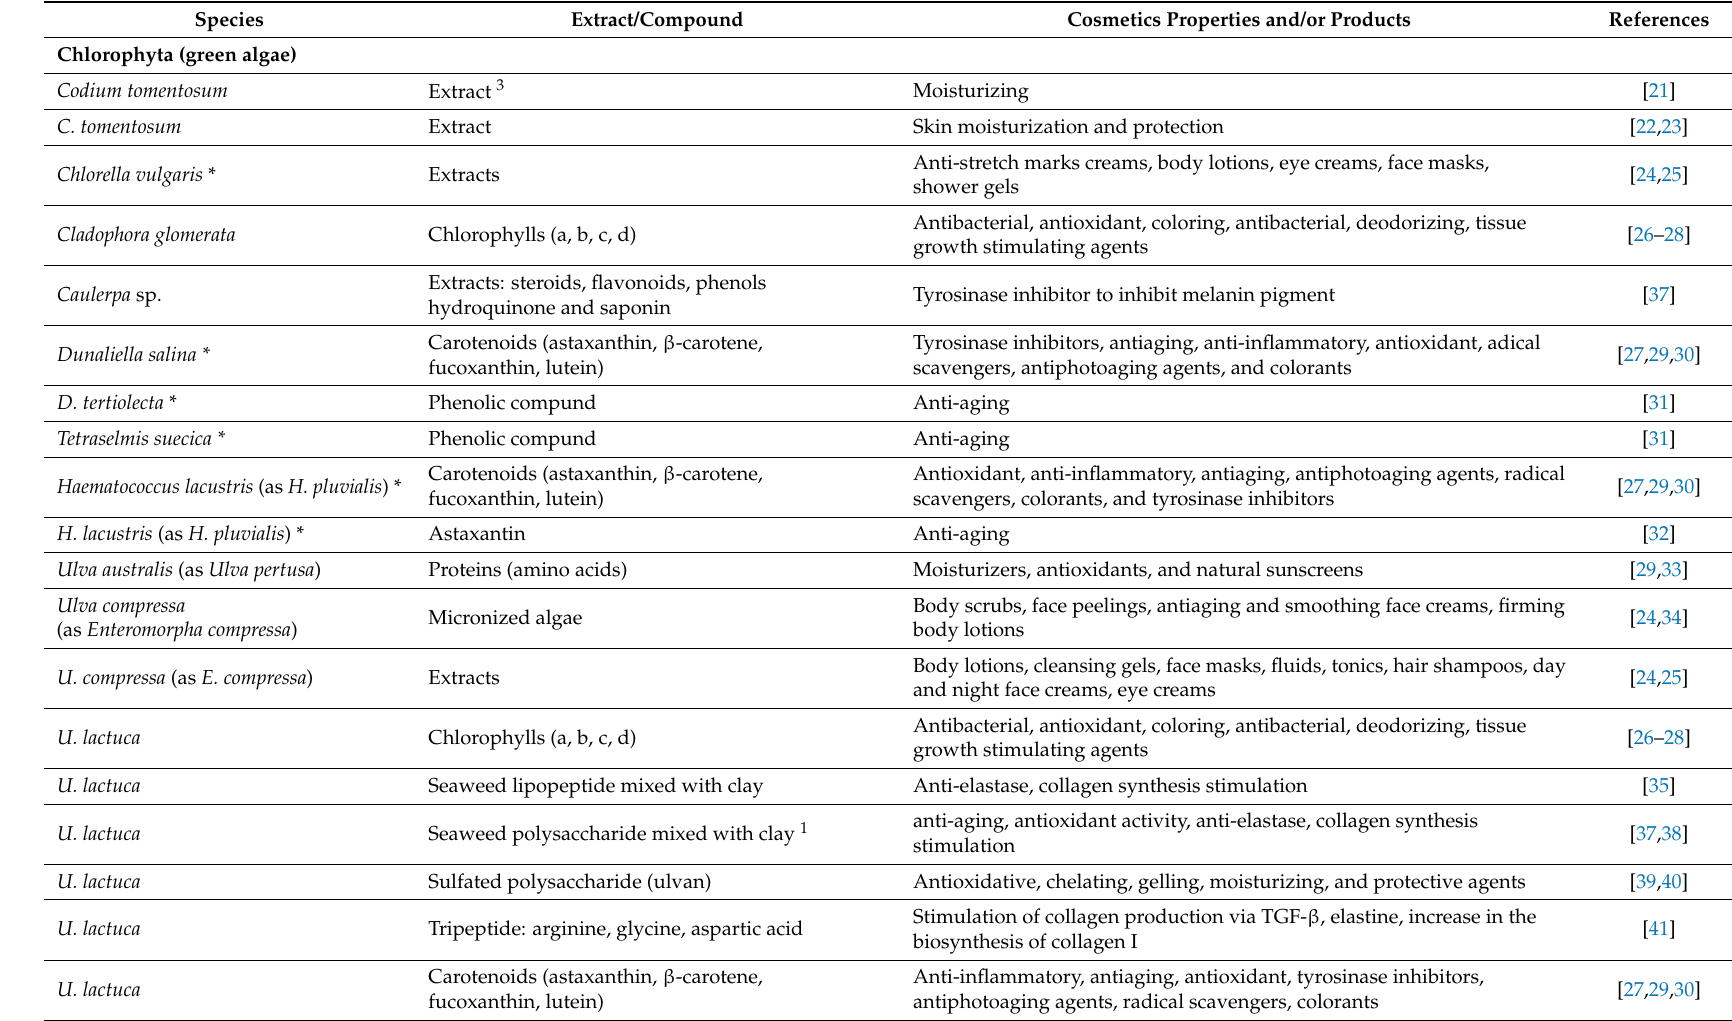
Table 1. Bioactive properties of some compounds extracted from